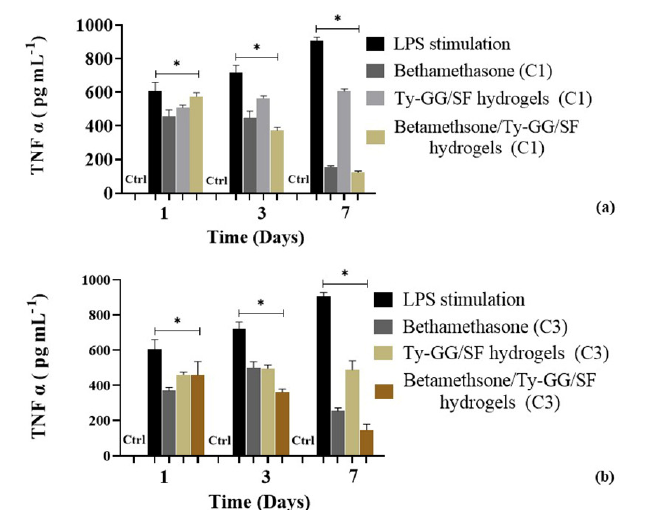
Figure 8. Amount of uncaptured TNF α under different conditions; cells with PMA without LPS stimulation (Ctrl), cells stimulated with LPS, betamethasone (C1), Ty–GG / SF hydrogels (C1) and Ty–GG / SF hydrogels with encapsulated betamethasone (C1) ( a ). Cells with PMA without LPS stimulation (Ctrl), cells stimulated with LPS, betamethasone (C3), Ty–GG / SF hydrogels (C3) and Ty–GG / SF hydrogels with encapsulated betamethasone (C3) ( b ). Significant * p < 0.05, nonparametric Kruskal–Wallis